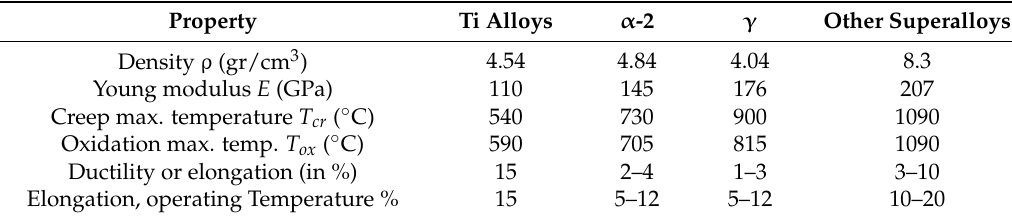
Table 1. Properties of titanium alloys and superalloys.